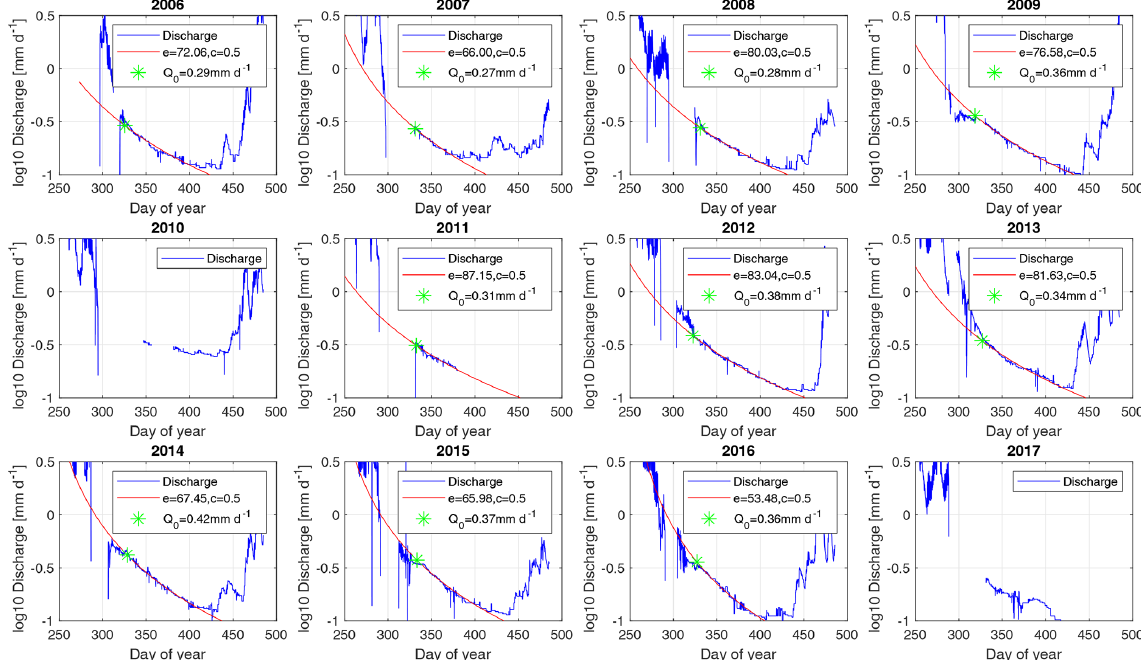
Figure 10. Annual recession analysis at the catchment outlet (GS3). The measured discharge is presented in blue (logarithmic scale), and the best fit of the power-law regression ( Q t = Q 0 ( 1 + 1 year larger than 365 indicates a recession spanning over the following year. The years 2010 and 2017 show large data gaps, so that no fit was